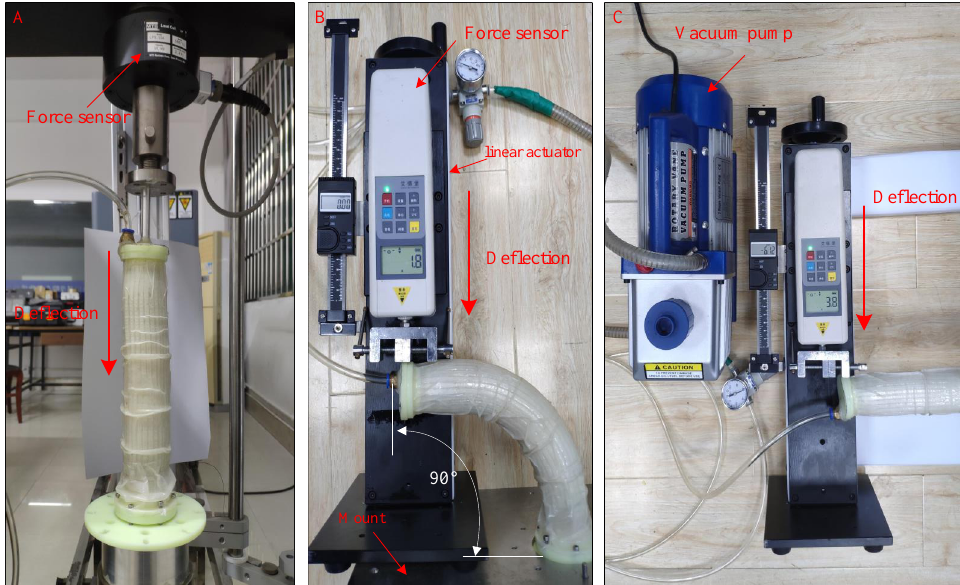
Figure 5. Experimental setups to evaluate the stiffness and flexibility of the TSCR. ( A ) Compression experiment with straight TSCR. ( B ) Lateral bending experiment at 90°. ( C ) Lateral bending experiment at